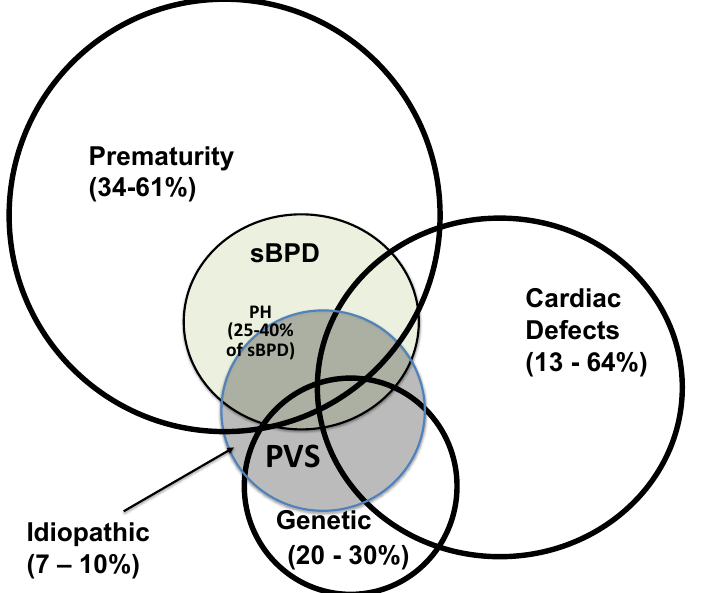
Figure 2. Epidemiological associations with pulmonary vein stenosis (PVS—blue central circle). sBPD—severe bronchopulmonary dysplasia (green). PH—pulmonary hypertension. Infants with sBPD and PVS are at risk for PH (light-blue). See text for